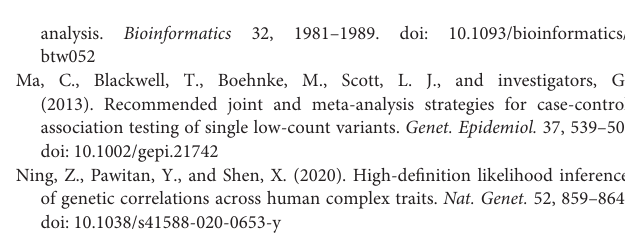
FIGURE 3 | < 5 10 − 4 . The default 1000 Genomes reference panel was used in LDSC. Bonferroni-corrected significant correlations with P < 0.05 / 435 are marked × with asterisks or dots, where those correlations that are only significant using one of the two methods are marked with asterisks and squares. (B) Scatterplot comparing the LDSC intercept and low MAF estimates. (C) Scatterplot comparing the LDSC intercept and the Z-cut ( the individual-level observational data and low MAF estimates; for the seven traits, we have data for, i.e., body mass index, basal metabolic rate, usual walking pace, standing height, birth weight, coffee consumed, and year ended full time